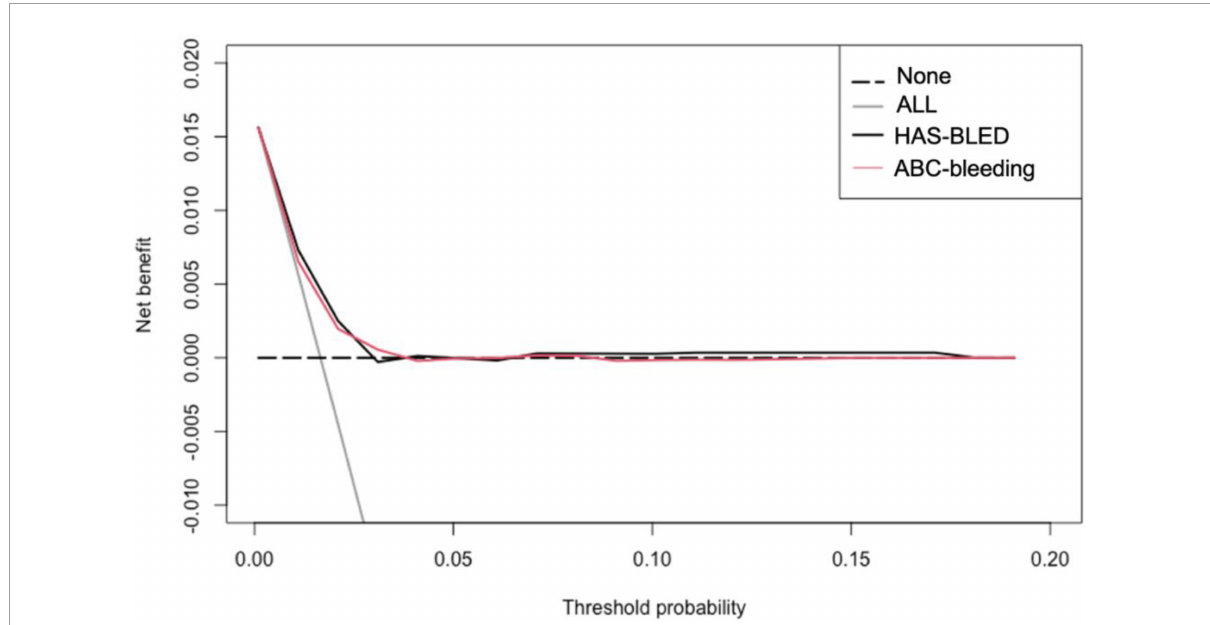
FIGURE4 Decision curves for ABC-bleeding risk and HAS-BLED scores. This analysis shows the clinical usefulness of each score based on a continuum of potential thresholds for major bleeding events ( x -axis) and the net benefit of using the score to stratify patients at risk ( y -axis) comparing to assuming that no patient will suffer from major bleeding